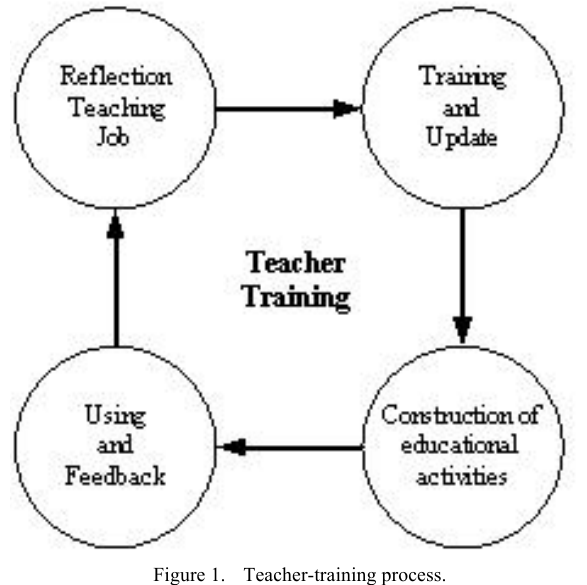
Figure 1. Teacher-training